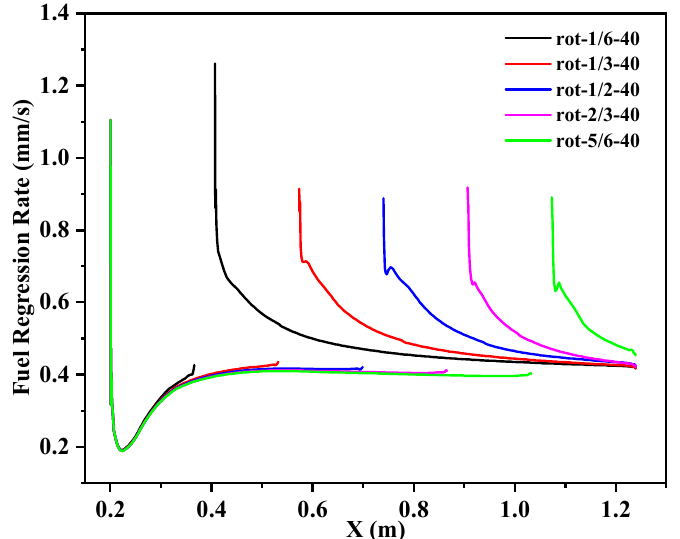
Figure 23. Fuel regression rates of point c along the motor axis in cases with various segmented positions.